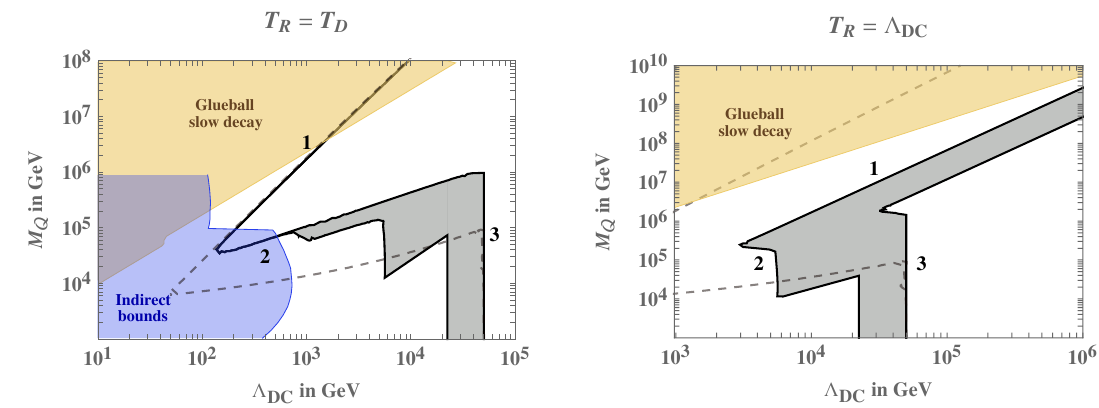
Figure 4 . On the black solid line (cid:10) (cid:31) (cid:16) (cid:10) DM . We also report (dashed line) the isocurve (cid:10) (cid:31) (cid:16) (cid:10) DM for the case where re-annihilation is not considered. The numbers indicate the three thermal histo- ries described in the text. In the yellow region the glueballs are either stable or have a lifetime bigger than 1 s. In the (cid:12)rst case they will over-close the Universe while in the latter they will spoil BBN, both cases are therefore forbidden. The blue region is ruled out by indirect searches, namely modi(cid:12)- cations of the CMB power spectrum, 21-cm line observables and indirect detection (see section